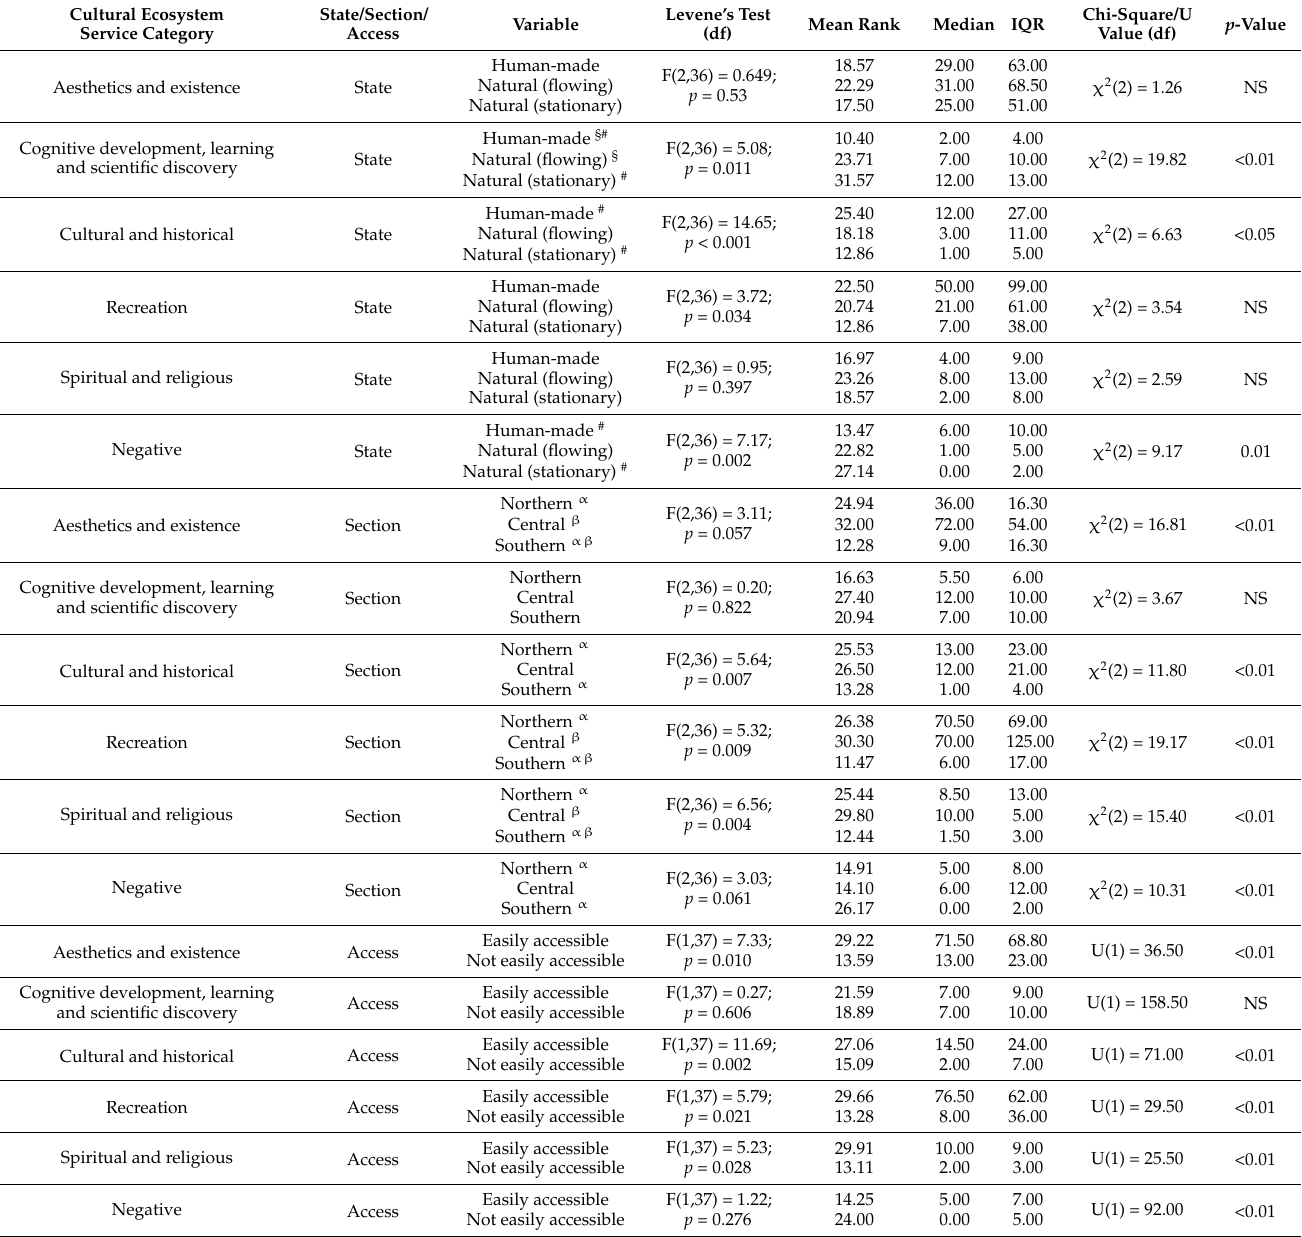
Table A3. Levene’s test (degrees of freedom), mean rank, median, interquartile range, chi-squared value (degrees of freedom) and significance of cultural ecosystem service variables based on state of water features, section in which water feature are located, and access to water features in the Table Mountain National Park. An § indicates significant difference between human-made and natural (flowing) variables, an # indicates significant difference between access variables. An α indicates significant difference between Northern and Southern variables, an β indicates significant difference between Central and Southern variables. NS indicates not